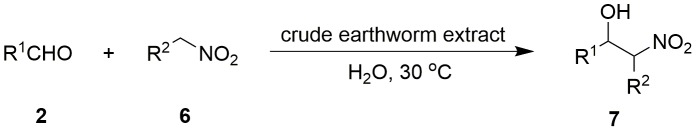
The crude earthworm extract catalysed Henry reactions.